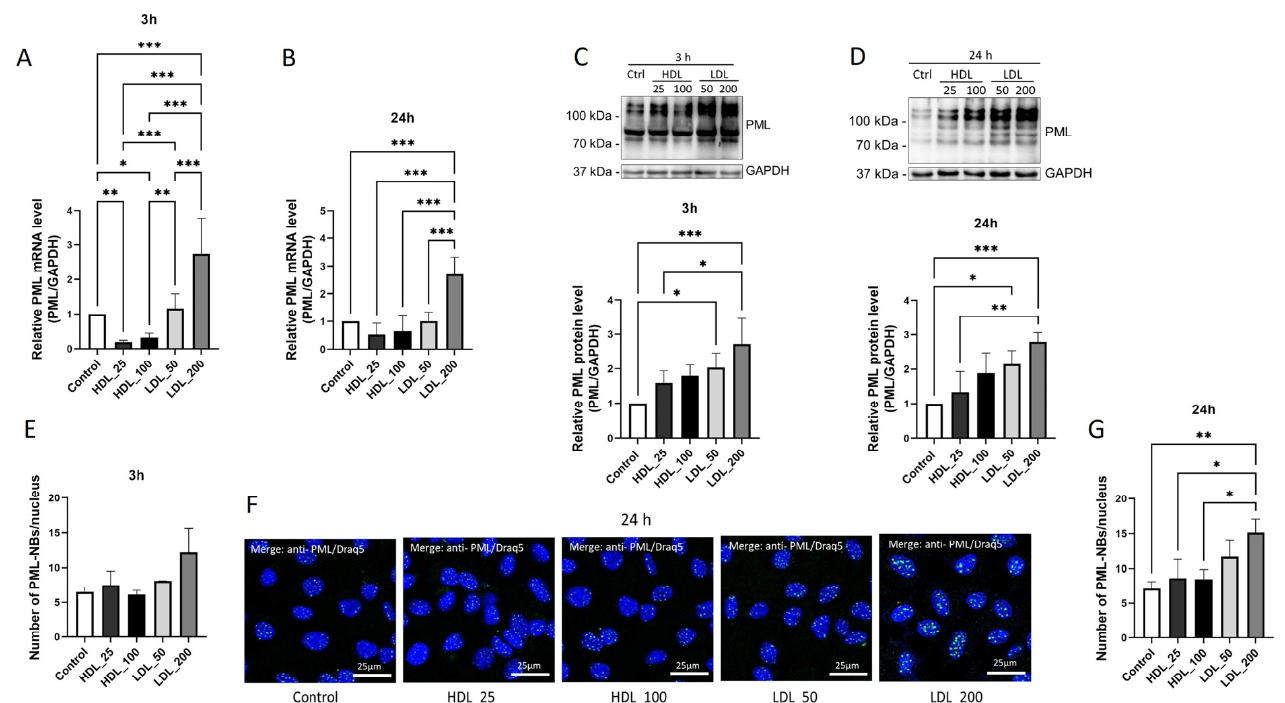
Figure 3. High doses of LDL increase PML expression and PML-NB assembly in endothelial cells. ( A , B ) PML mRNA levels in EA.hy926 cells were quantified by RT-qPCR after incubation with high or low concentrations of isolated HDL or LDL for 3 h ( A ) or 24 h ( B ). Expression values relative to control. n = 3 ( A ), n = 4 ( B ), one-way ANOVA. ( C , D ) Immunoblotting was performed on total lysates of EA.hy926 cells incubated with HDL or LDL in high or low concentrations for 3 h ( C ) or 24 h ( D ). Expression values relative to control. Representative immunoblots of n = 4, one-way ANOVA. ( E ) Representative images of EA.hy926 cells incubated with isolated HDL or LDL in high or low concentrations for 24 h and subjected to immunocytochemistry with an anti-PML (green) antibody and Draq5 staining for labeling of cell nuclei (blue). Representative images of n = 3 experiments. ( F , G ) Number of PML-NBs per nucleus in EA.hy926 cells incubated with isolated HDL or LDL in high or low concentrations for 3 h ( F ) or 24 h ( G ). n = 3, one-way ANOVA. All graphs shown as mean ± SD, * p < 0.05, ** p < 0.01, *** p < 0.001.